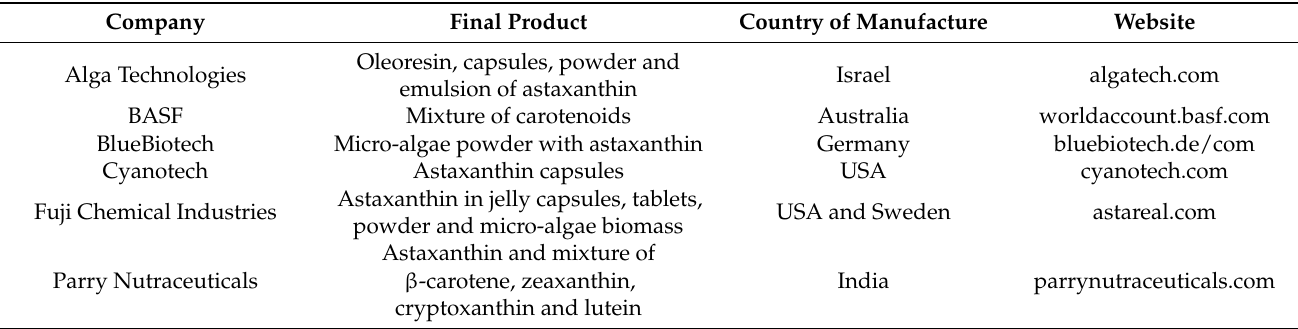
Table 3. Companies producing carotenoids by biotechnological